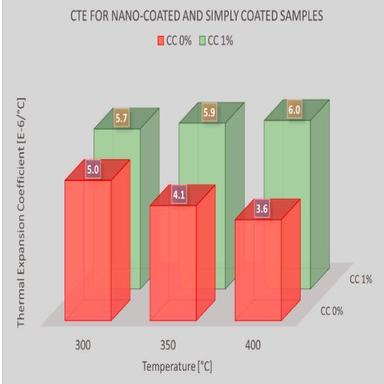
Average CTE values of C/C coated by Al2O3-based varnish and by the coating enriched by 1 wt% of SiO2 nano-sphere inclusion within the thermal conductivity experiments temperature range.